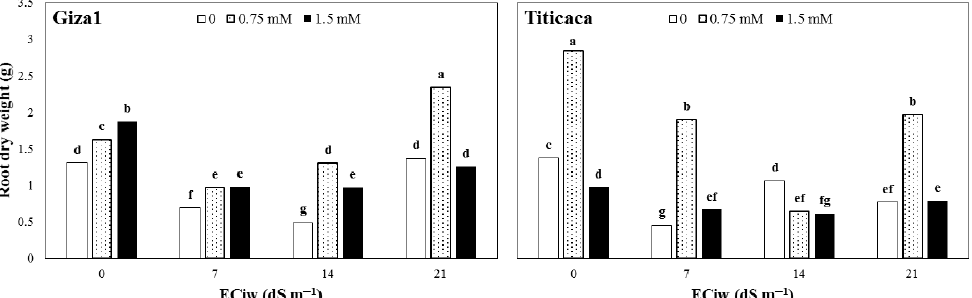
Figure 2. Root dry weight of two quinoa cultivars treated by varied salicylic acid concentrations grown under different salinity of irrigation water (ECiw). The columns with at least a similar letter in each figure are not significantly different based on LSD at 1% probability level.